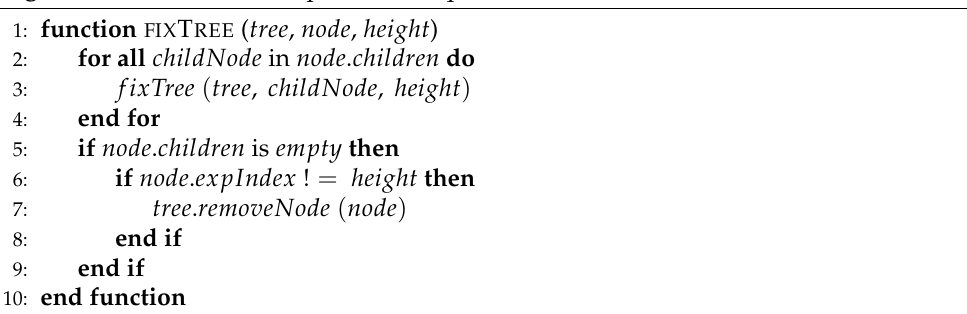
Algorithm 3 Remove Incomplete Sub-sequence from the